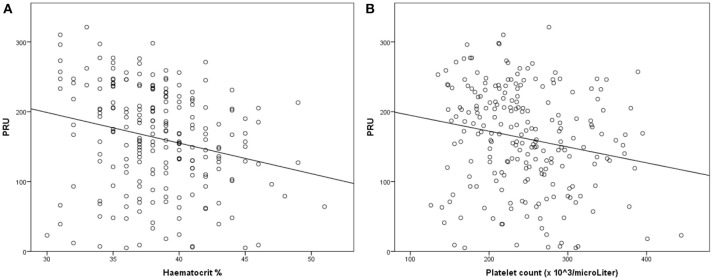
Linear regression analysis for the association of platelet reactivity [measured using Platelet Reaction Units (PRU)] with the haematocrit (Hct) value (A) and platelet count (B). Decreased platelet reactivity is associated with an increased Hct value and platelet count.